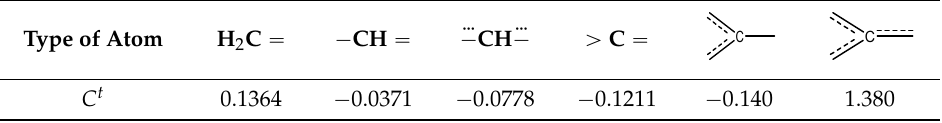
Figure 7. Behavior of the free valence, the E-States and GDIs for atoms from 19 conjugated molecules. Table 9. C t values for each type of carbon atoms.